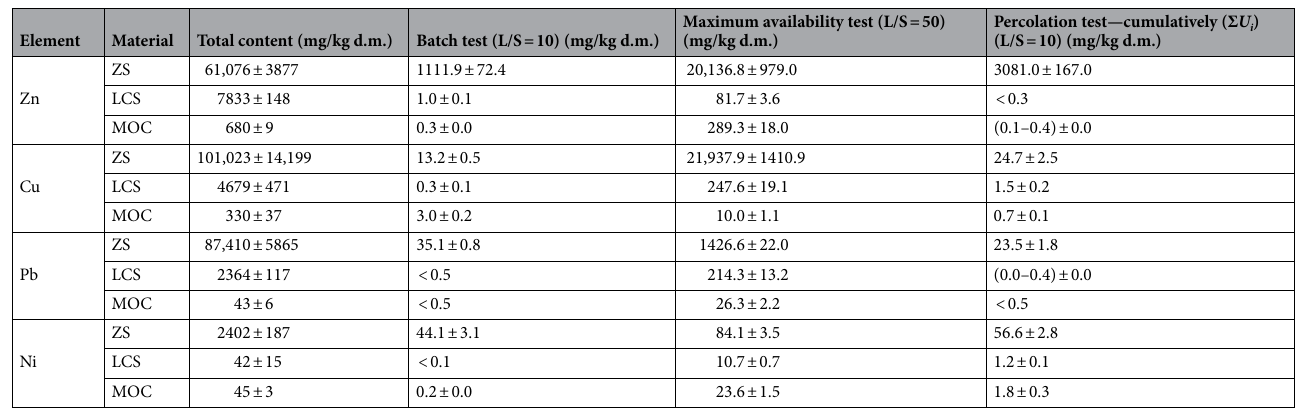
Table 3. Total heavy metals content and their concentration obtained in batch test, maximum availability test (mean ± SD, n = 3) and percolation test (mean ± u c (Σ U i ), n = 7).